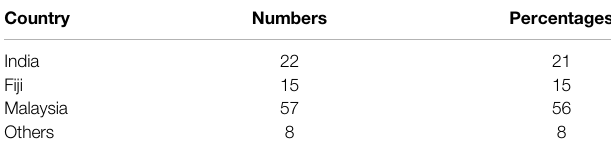
TABLE 4 | Country represented by participants.